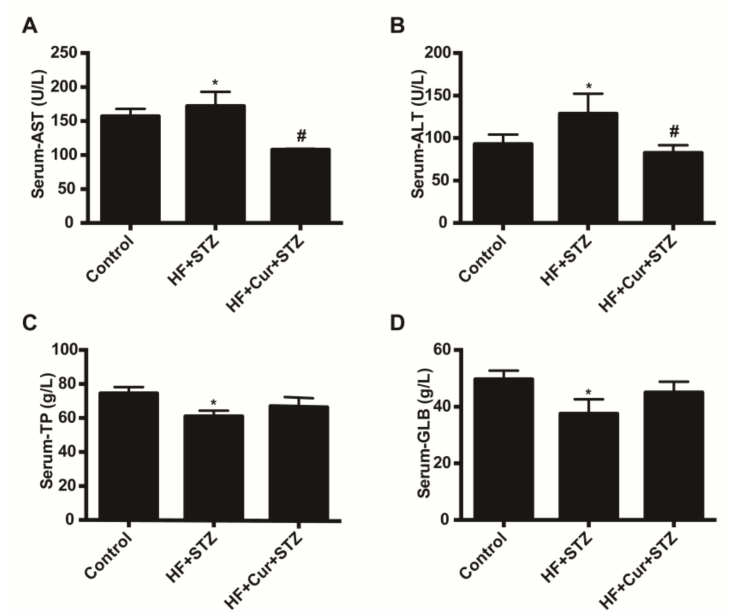
Figure 4. The e ff ect of curcumin intervention on blood lipid levels in rats fed a high-fat diet then treated with streptozotocin. ( A ) The e ff ect of curcumin intervention on total cholesterol (TC). ( B ) The e ff ect of curcumin intervention on triglycerides (TG). ( C ) The e ff ect of curcumin intervention on high-density lipoprotein cholesterol (HDL-C). ( D ) The e ff ect of curcumin intervention on low-density lipoprotein cholesterol (LDL-C). The data are expressed as the mean ± SEM. * p < 0.05 compared with the control group; # p < 0.05 compared with the HF + STZ group. Control ( n = 6), HF + STZ ( n = 10), and HF + Cur + STZ ( n = 10).